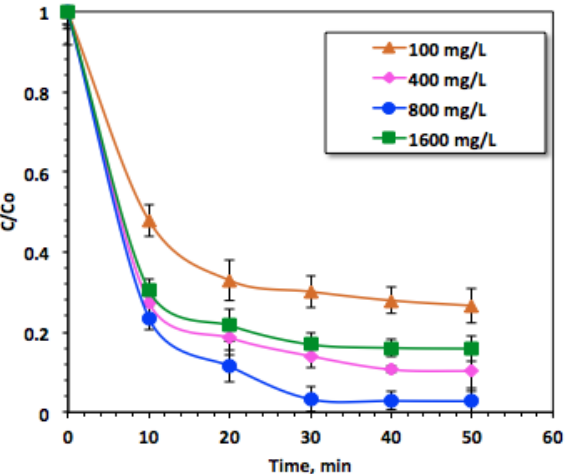
Figure 6. Effect of H 2 O 2 concentration on the photo-Fenton system.